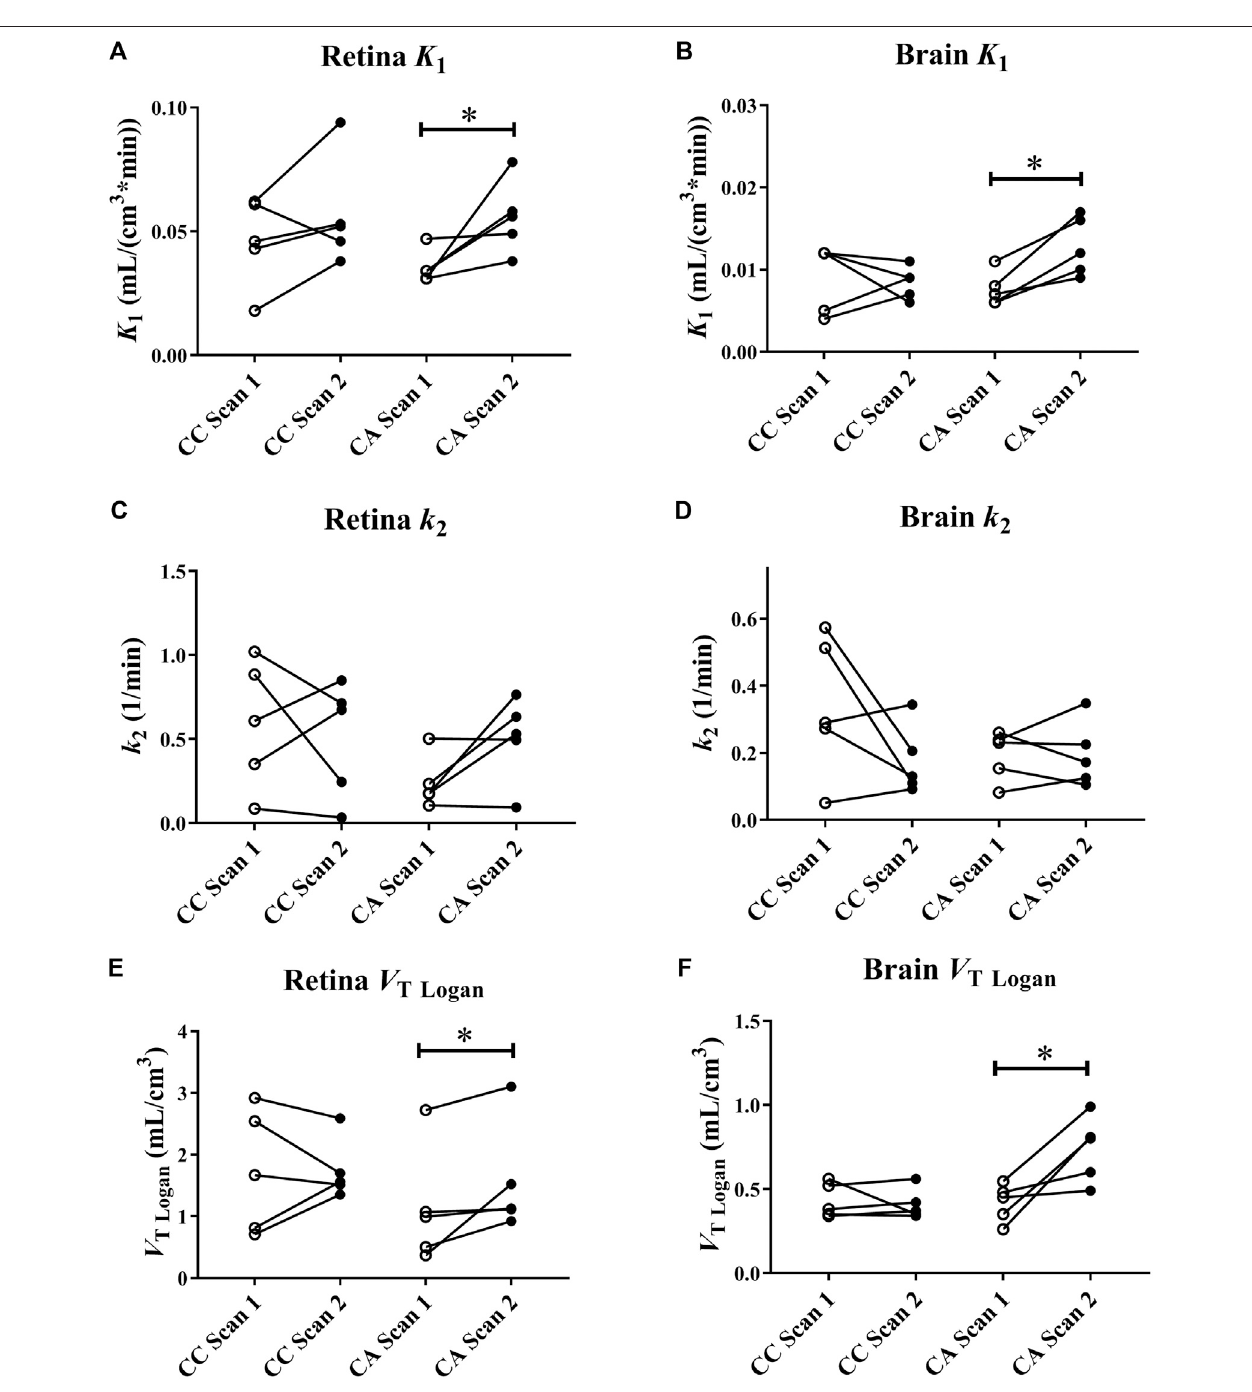
FIGURE2| [ 11 C]tariquidar modellingoutcomeparameters( K 1 and k 2 estimated from 2T4K model and V T estimated withLogangraphicalanalysis)for retina (A,C, andE) andwholebraingreymatter (B,D,andF) inc.421CC(CC)andc.421CA(CA)subjectsforbaselinescan(scan1)andscanduringABCB1inhibition(scan2).Brain data are taken from Bauer et al. (Bauer et al., 2016). * p < 0.05, Wilcoxon signed rank test.